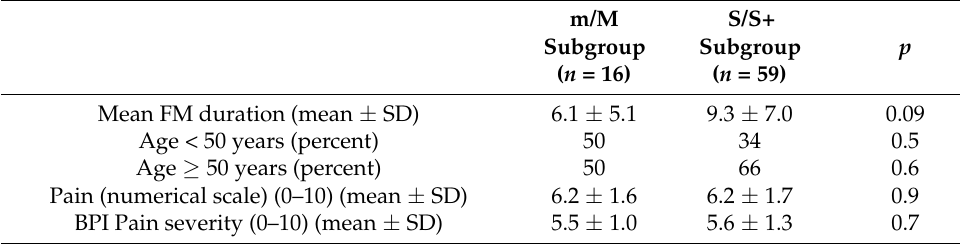
Table 3. Plasma and erythrocyte Mg concentrations after treatment ( n = 75).